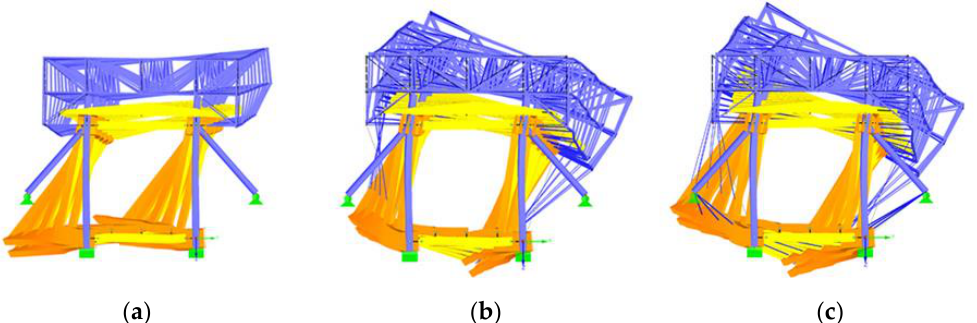
Table 4. Results of the modal analysis after the second model update ( m eX , m eY , m eZ : translational Figure 10. Cross-section of the torsional modal shape: ( a ) original model (2nd mode of vibration,